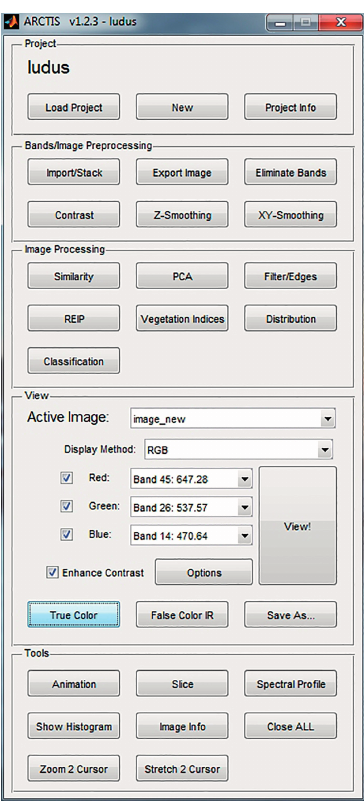
Figure 3. The graphical user interface (GUI) of